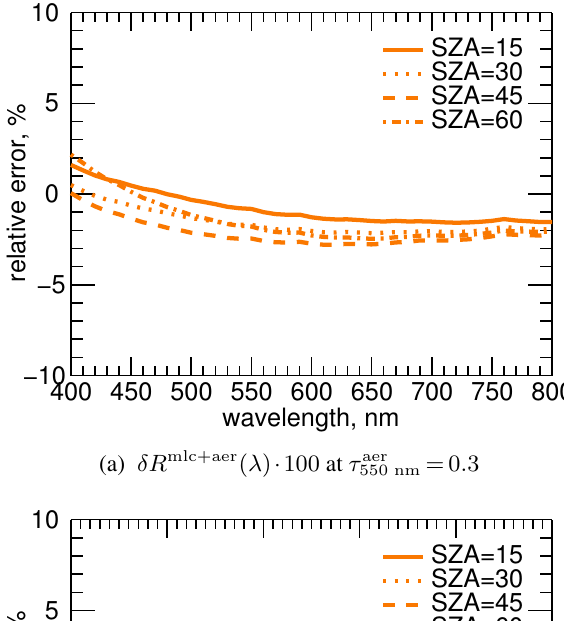
Table 3: Quantitative comparison between SMART and 6S by statistical means for the limited conditions as defined in Table 1. SMART uses the HG phase function; 6S used the phase function from Mie calculations. R 2 denotes the squared correlation coefficient, RMSE the root mean square error and NRMSE the normalised RMSE. sensor altitude